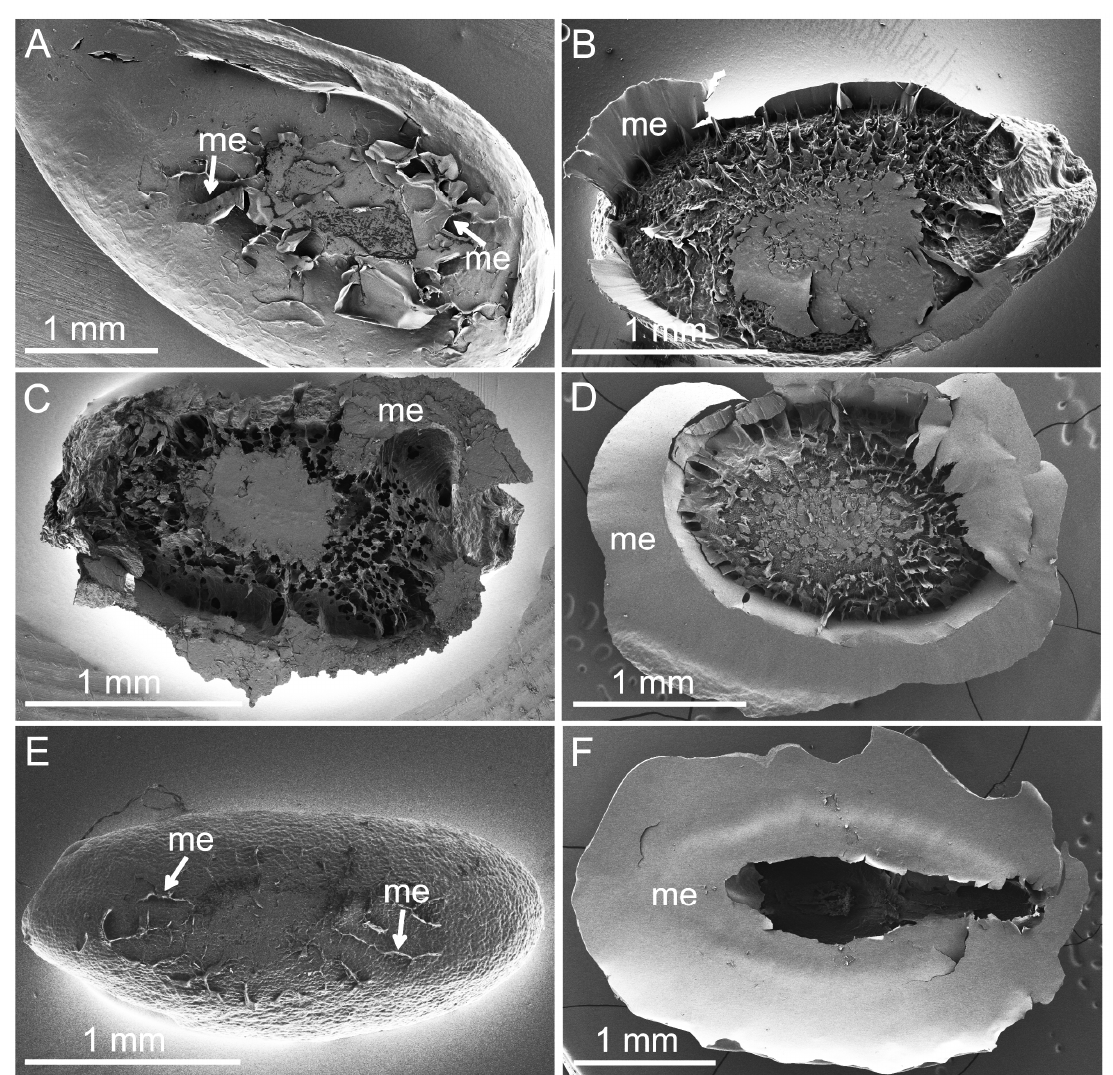
Figure 5. Seed mucilage structure in the fractures of the adhesive layer after pull-off measurements. ( A ) L. usitatissimum seed with small remains of the mucilage envelope (me, arrows) on the seed surface; ( B ) L. sativum ; ( C ) O. basilicum ; ( D ) S. hispanica ; ( E ) P. lanceolata and visible small fragments of the mucilage envelope (me, arrows); ( F ) P. ovata . The mucilage envelope after drying formed a thin, transparent layer. After measurements, when the seed was detached from the glass, that thin layer stayed partially attached to the seed, which is visible as small ( A , E ) or larger fragments on its surface ( B – D , F ).